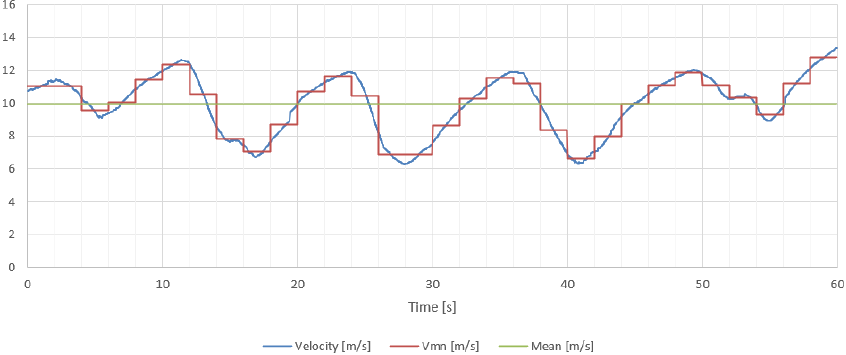
Figure 10. Speed averages in windows of 2 (s) and total average in one minute.